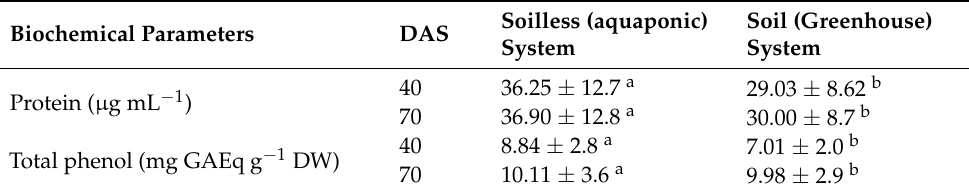
Table 2. Biochemical parameters of Ocimum basilicum in soilless (aquaponic) and soil (greenhouse) systems at 40 and 70 DAS. Biochemical